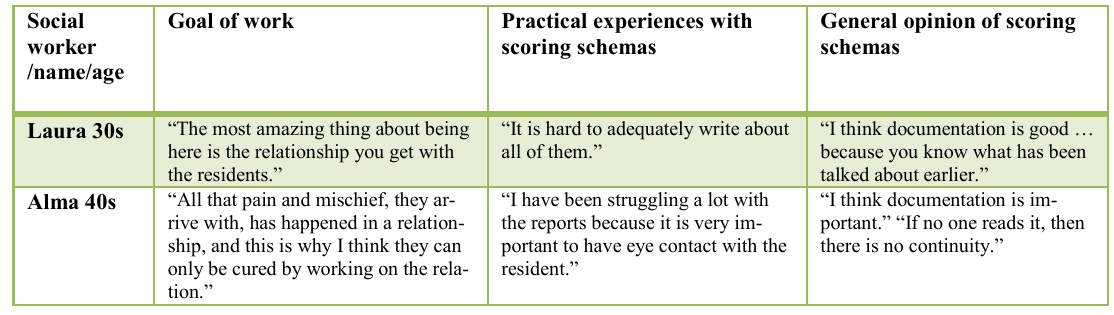
Social workers reflections on documenting their work in scoring